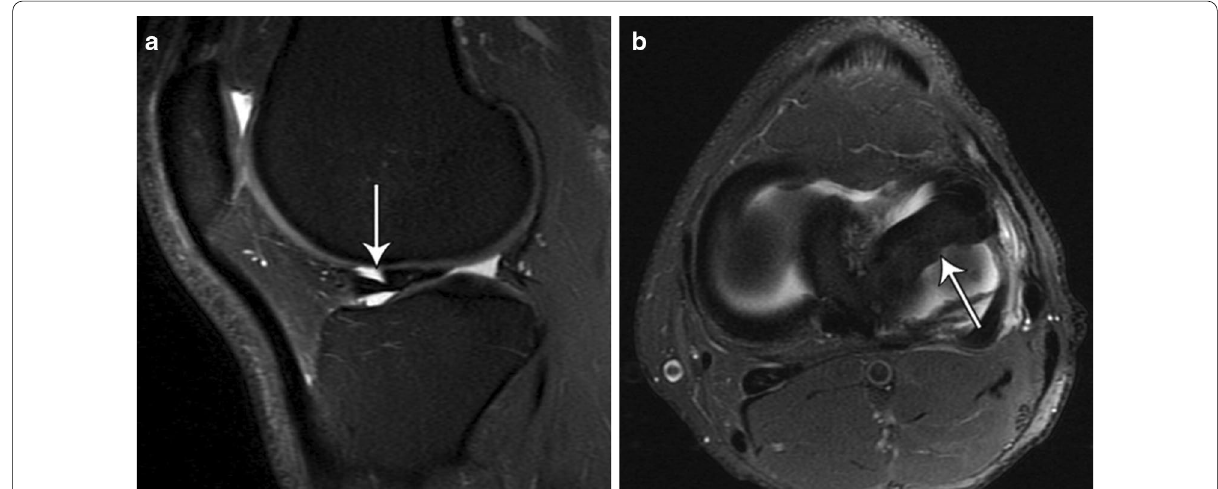
Fig. 19 Sagittal T2‑weighted fat‑suppressed MR image ( a ) shows a double delta sign (thin arrow), typical for flipped meniscus. Axial image ( b ) shows anterior dislocation of the posterior horn of lateral meniscus (thin arrow)